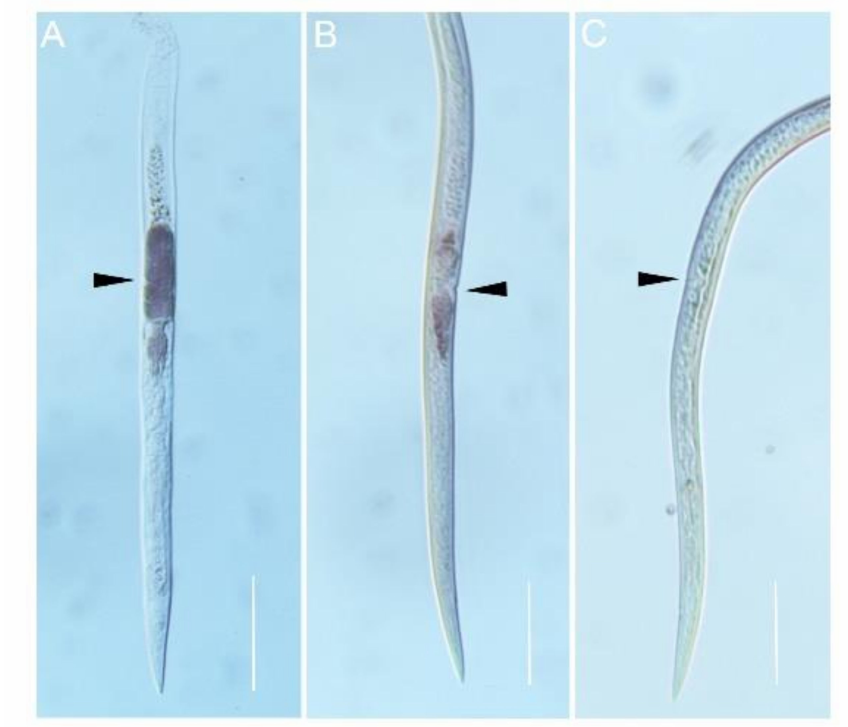
Figure 4. Localization of AbGH16 gene expression in A. besseyi using in situ hybridization. AbGH16-1 ( A ) and AbGH16-2 ( B ) probes were extremely strong with specific dark staining in the female gonads, while no such staining pattern was observed in the negative control ( C ). The black arrows indicate female gonads. Scale bar = 50 µ m.